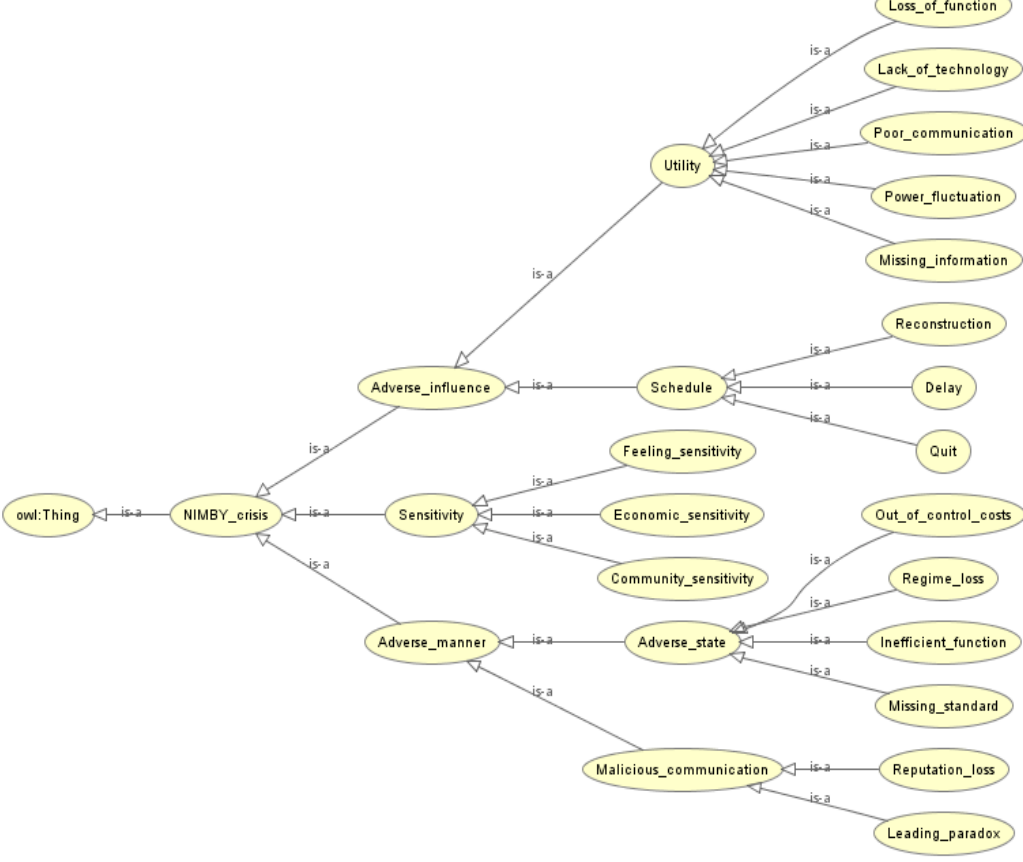
Figure 5. MSW risk ontology model.